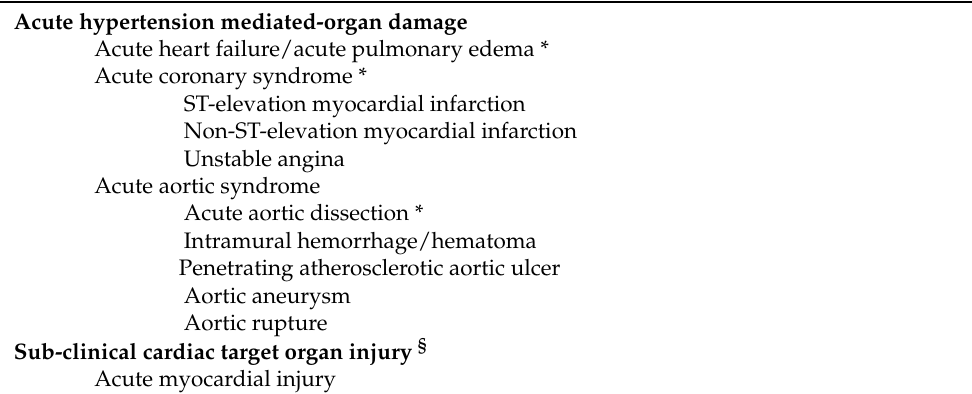
Table 2. Cardiac complications of hypertensive